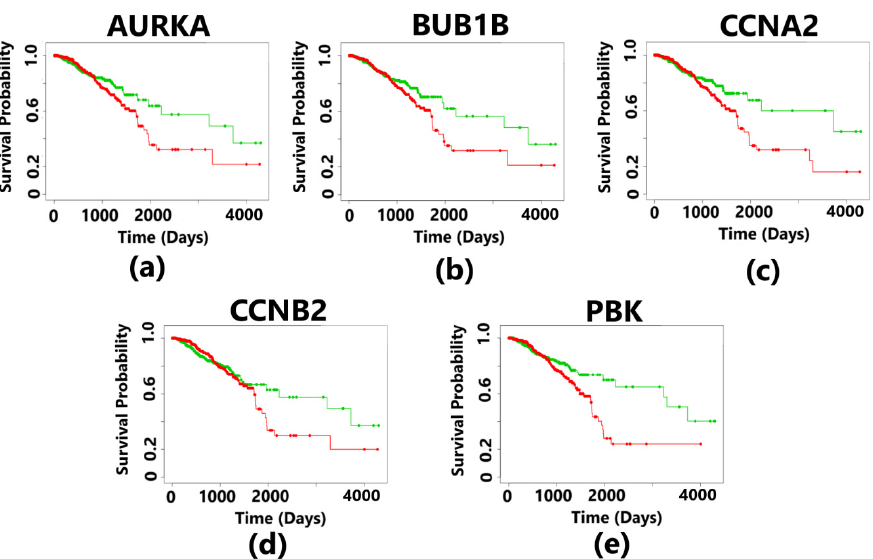
Figure 10. Kaplan–Meier plots showing the survival analysis corresponding to 5 hub genes in breast cancer. The patients were divided into high- and low-risk groups. The overexpression of all the hub genes resulted in the poor survival outcomes, which is less than 3 years for the patients suffering from breast cancer. The plot in green color indicates the survival of patients in the low-risk group, and the plot in red color represents the survival of patients in the high-risk group. The survival curves are statistically significant with a p -value less than 0.05 ( p -value < 0.05). ( a ) The overexpression of the AURKA gene indicates a survival probability of 50% for patients in the low-risk group and 25% survival of the patients in the high-risk group. The positive control has 482 samples, and the negative control has 480 samples. ( b ) The overexpression of the BUB1B gene in- dicates a survival probability of 48% for patients in the low-risk group and 18% survival of the pa- tients in the high-risk group. The positive control has 483 samples, and the negative control has 479 samples. ( c ) The overexpression of the CCNA2 gene indicates a survival probability of 56% for pa- tients in the low-risk group and 18% survival of the patients in the high-risk group. The positive control has 481 samples and the negative control also has 481 samples. ( d ) The overexpression of the CCNB2 gene indicates a survival probability of 54% for patients in the low-risk group and 22% survival of the patients in the high-risk group. The positive control has 484 samples and the nega-